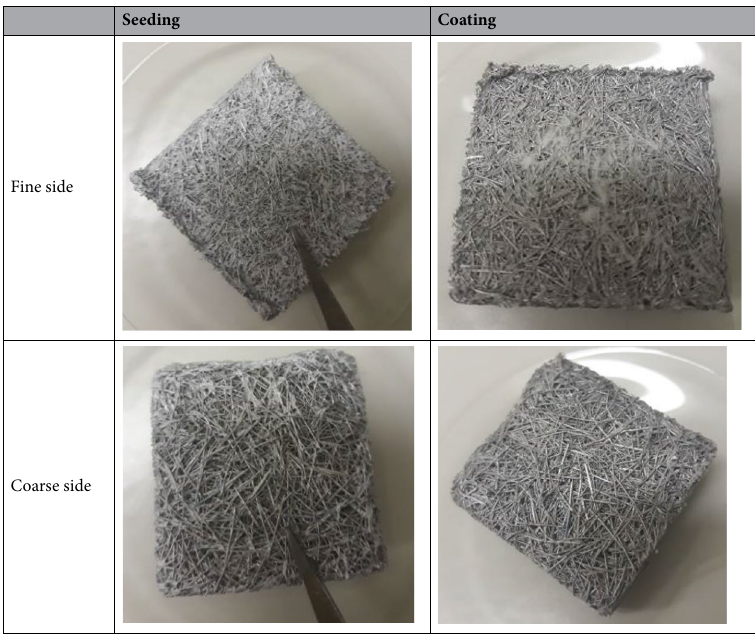
Table 1. CaCl 2 seeding and coating on aluminium fibre structures.